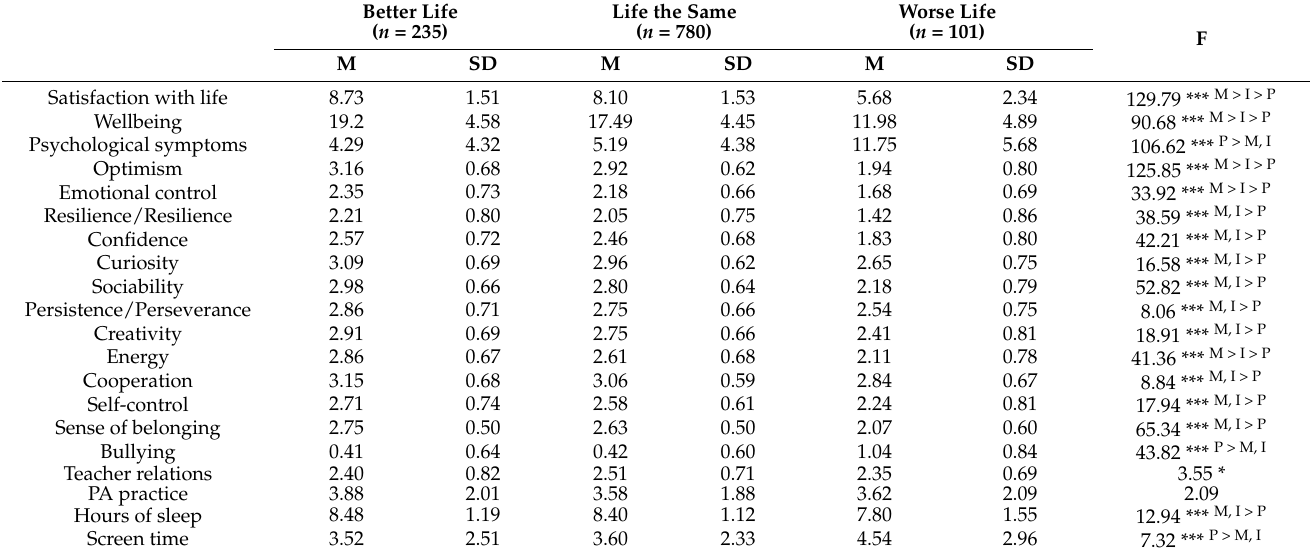
Table 5. Comparisons between groups, according to the evaluation of current life, in the second cycle of primary